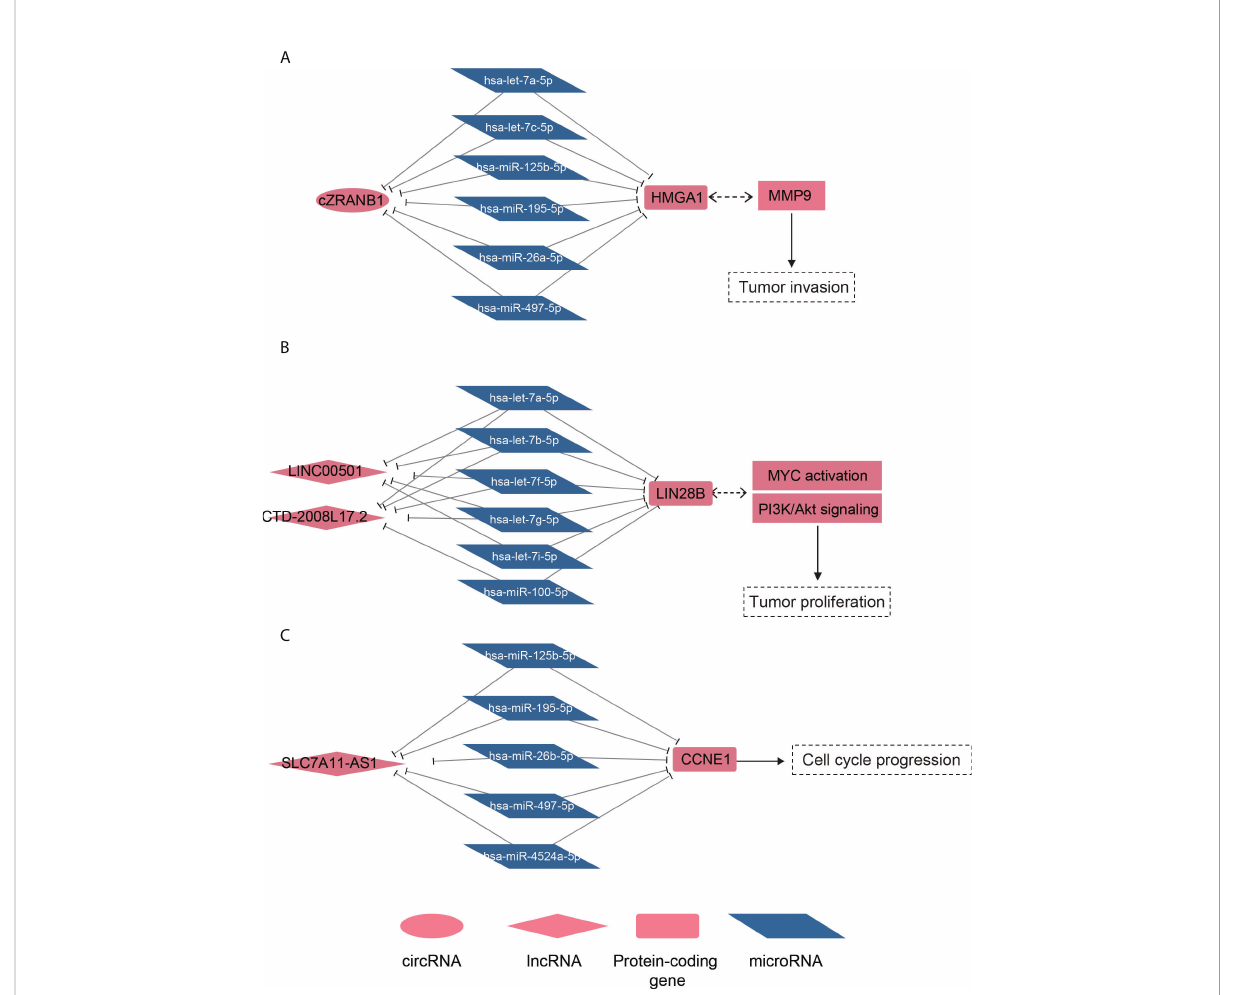
FIGURE 5 The ceRNA networks for dysregulated ncRNAs. The schematic diagrams for the cZRANB1, LINC00501/CTD-2008L17.2, and SLC7A11-AS1 are displayed in (A-C) . The round, rhombus, rectangle, and rhomboid symbols represent the circRNAs, lncRNAs, mRNAs, and microRNAs, respectively. The symbols fi lled with red or blue color represent up- or downregulated in